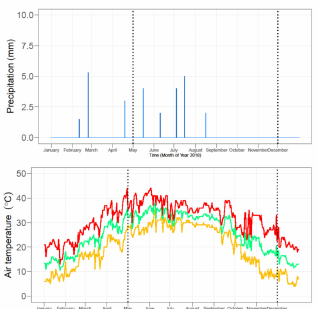
Figure 1. Daily total precipitation and average daily minimum (T min ), mean (T avg ), and maximum (T max ) air temperature. Daily precipitation in Multan, Pakistan, from January to December 2018. The dotted lines show the duration of the experiment from the sowing to the harvesting of the cotton